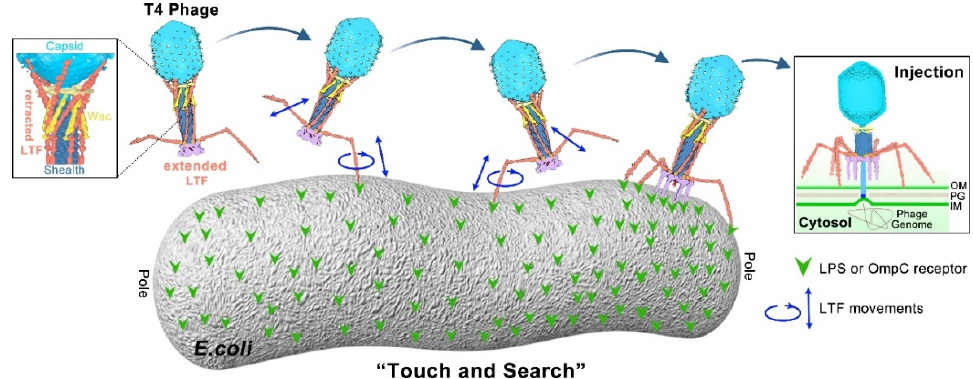
Figure 3. “Touch and Search” model of LTFs during T4 infection initiation. In the free state, most phages have three to four retracted LTFs on average. Each fiber is likely in a dynamic “retracted– extended” equilibrium that does not need chemical energy to maintain. Upon infection, the trimeric LTF “tip” allows weak and unstable interaction with the receptor, probably causing the “tip” to move up and down as well as rotationally (“association–dissociation” equilibrium). The “association–dissociation” and “extended–retracted conformation” dynamic equilibriums allow the T4 phage to randomly walk across the host surface to search for an optimal infection site [51].